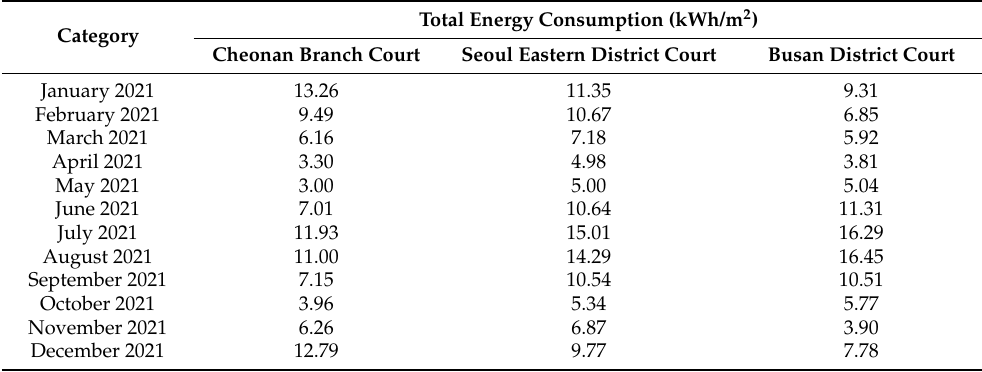
Table 8. Total energy consumption of Korean courthouse buildings (G-SEED certified and before insulation thickness standard revision).